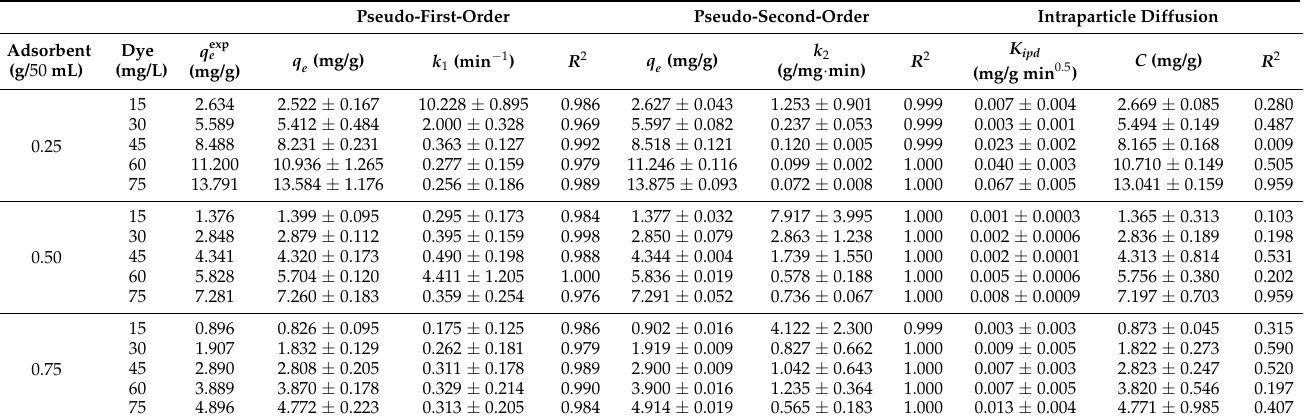
Table 8. Results of kinetic models considered for ADY—Drimaren Yellow Dye